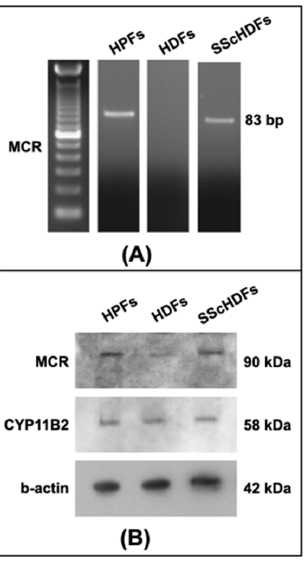
Figure 2. MCR and CYP11B2 expression in fibroblasts. ( A ) RT ‐ PCR showed the presence of MCR mRNA in HPFs and SScHDFs but not in HDFs. ( B ) Western blot analysis confirmed the presence of MCR in HPFs and also in HDFs and SScHDFs. Furthermore, it showed a different receptor amount in cells analyzed: HPFs and SScHDFs expressed more than double the amount of MCR than HDFs (1.27 and 1.03, respectively); the CYP11B2 amount was similar in every kind of fibroblasts. (HPFs: human pulmonary fibroblasts; HDFs: human dermal fibroblasts; SScHDFs: scleroderma dermal fibroblasts; MCR: mineralocorticoid receptor; CYP11B2: cytochrome P450 11B2). HPFs and HDFs stimulated by ET ‐ 1 for 24 h (Figure 3) did not show changes in MCR and α‐ SMA mRNAs before and after ET ‐ 1 stimulation. To the contrary, in HPF and HDF cultures, supernatants, the protein levels of collagen ‐ 1, TGF ‐β , and PDGF before and after ET ‐ 1 stimulation for 24 or 48 h changed (Figure 4).